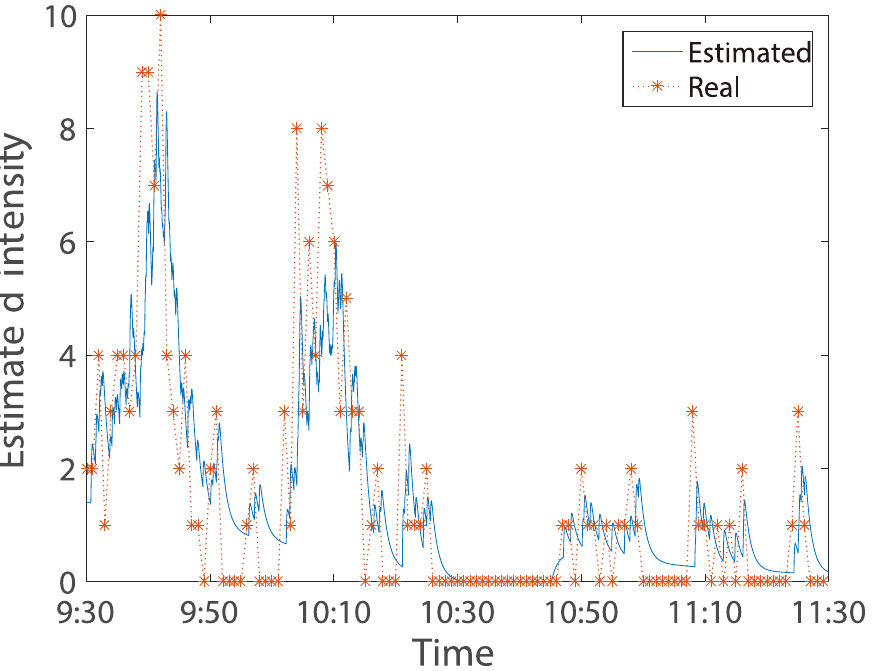
Fig 3. The estimated intensity of aggressive market buy orders in the morning of April 10th, 2003 (events per minute) (blue line). The kernel function used in Hawkes model is given in Eq (2). The real intensity, i.e. the number of aggressive market buy orders in every minute, is charted by orange